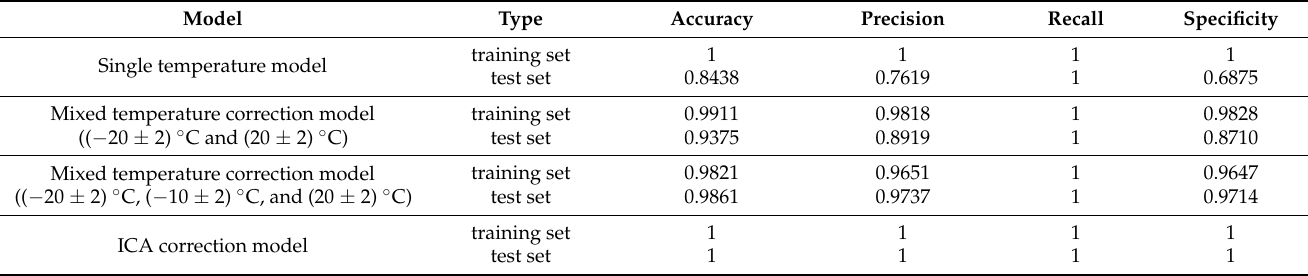
Table 3. Results of four